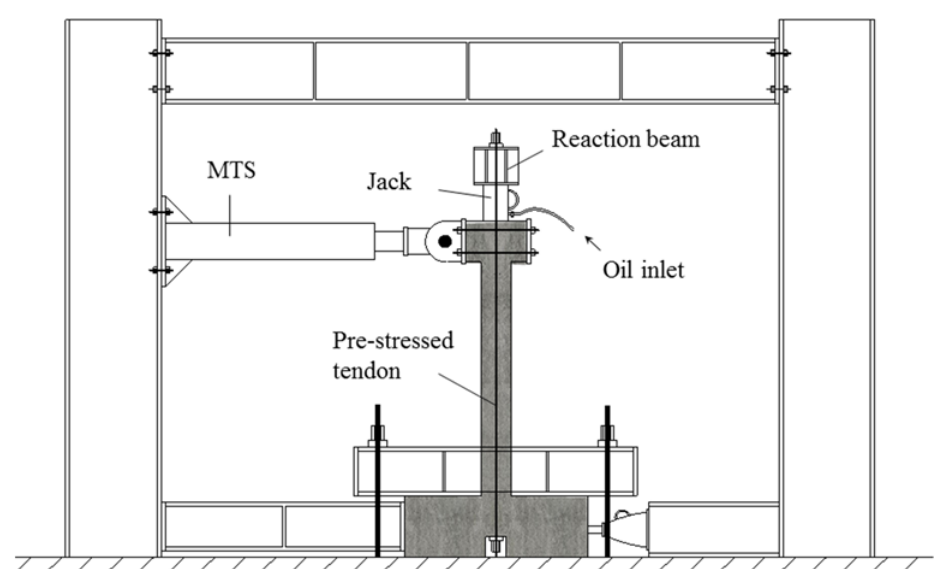
Figure 2. Static test set-up.